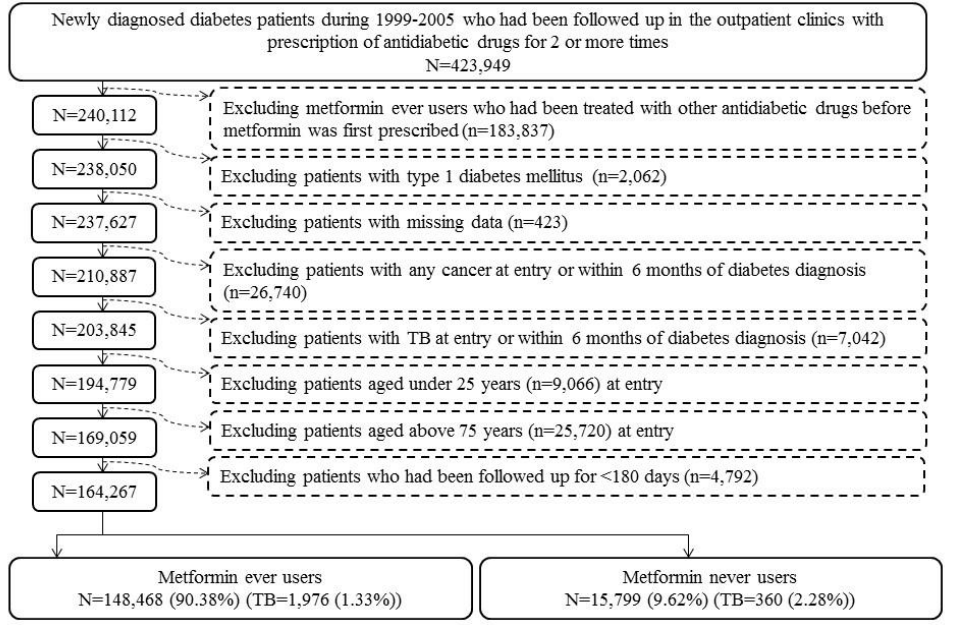
Figure 1. The procedures for creating a cohort of metformin ever and never users from